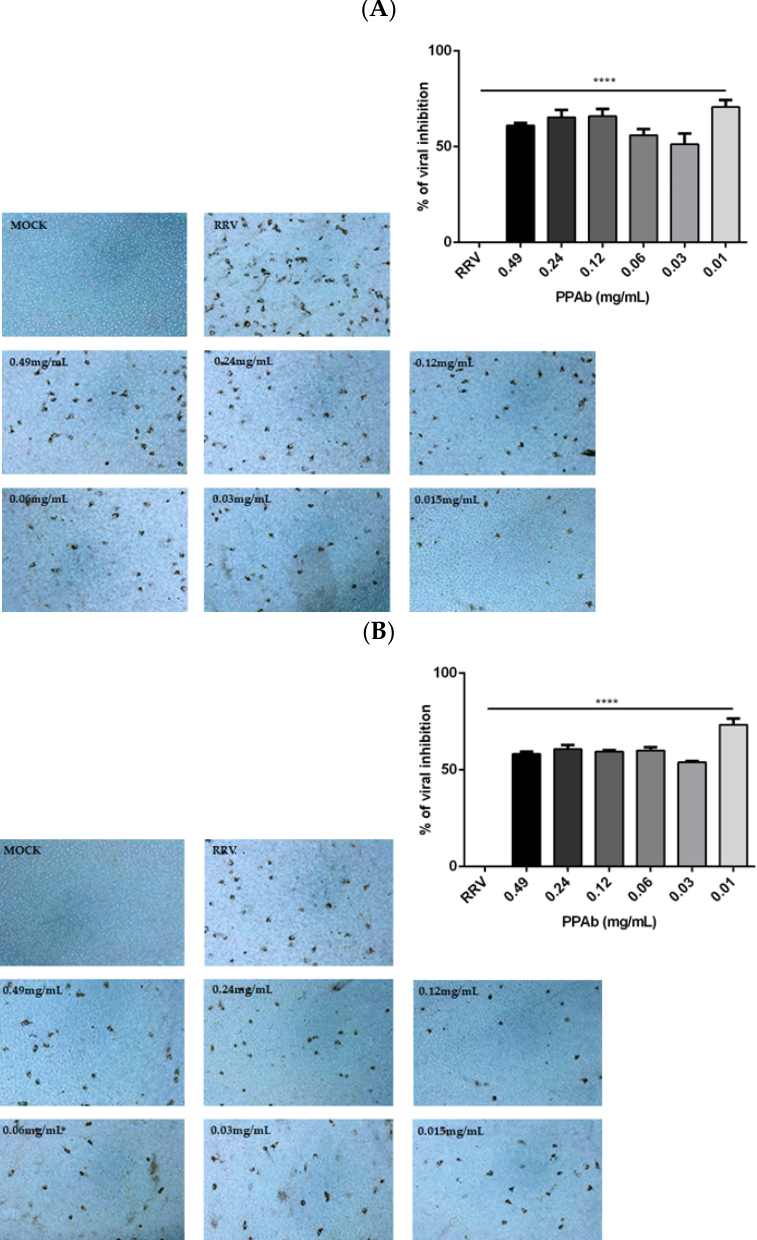
Figure 2. Virucidal activity of the PPAb against rotavirus. Different concentrations of PPAb were incubated with infectious RV (RRV/final MOI = 0.1) particles for 2 h ( A ) or 4 h ( B ). PPAb -RV mixtures were added to MA104 cells for 1 h at 37 °C and 5% CO 2 for 1 h. The inocula were then removed and replaced by fresh culture medium without FBS, and incubated for 10 h. Infectious focus forming units (FFUs) were quantified by staining of intracellular RV capsid proteins using rabbit polyclonal anti-TLP antibodies (primary antibody), goat anti-rabbit IgG (H + L) antibody conjugated to HRP (secondary antibody), and AEC (3-amino, 9-ethyl carbazole) with 0.02% H 2 O 2 . MOCK: non-RRV infected cells; RRV: RV-infected cells. Bars represent mean ± SD. **** p < 0.0001 for comparisons with the control of RRV-infected cells; unpaired Welch’s t -test. All experiments were done in triplicates and repeated independently three times. Representative photographs of each condition (100X).